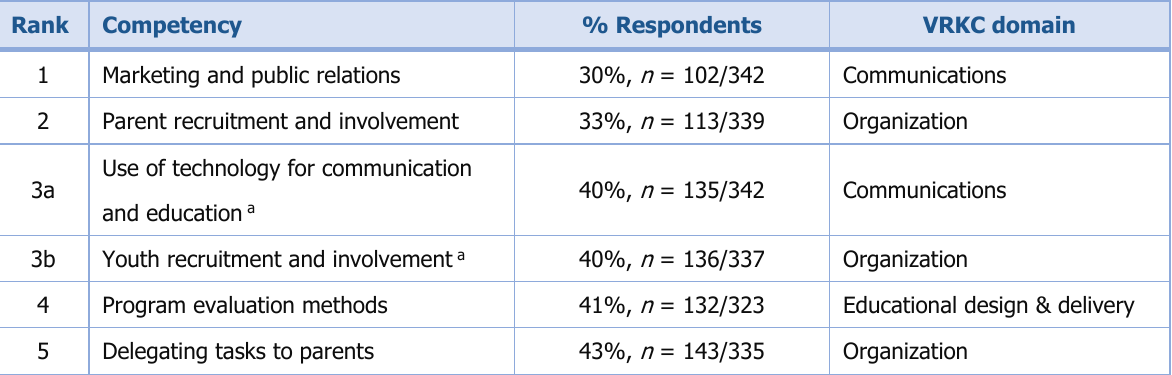
Table 3. Top Five Competencies Volunteers were Least Confident